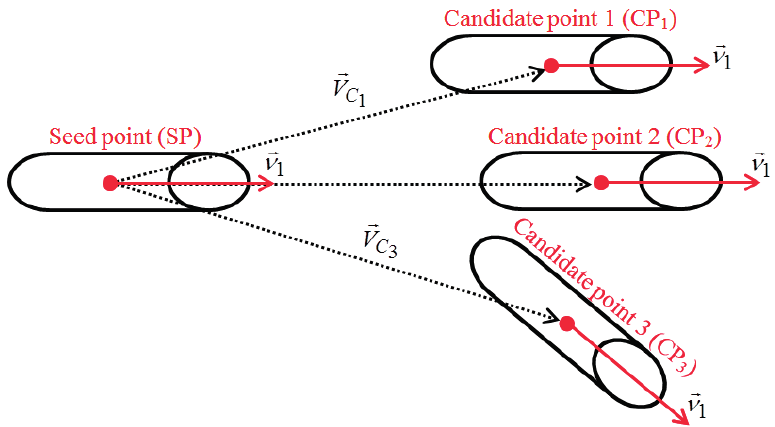
Figure 14. Bus pipe segmentation process in which all points (incorporating the seed point (SP) and three candidate points (CP i )) are assumed to belong to cylindrical